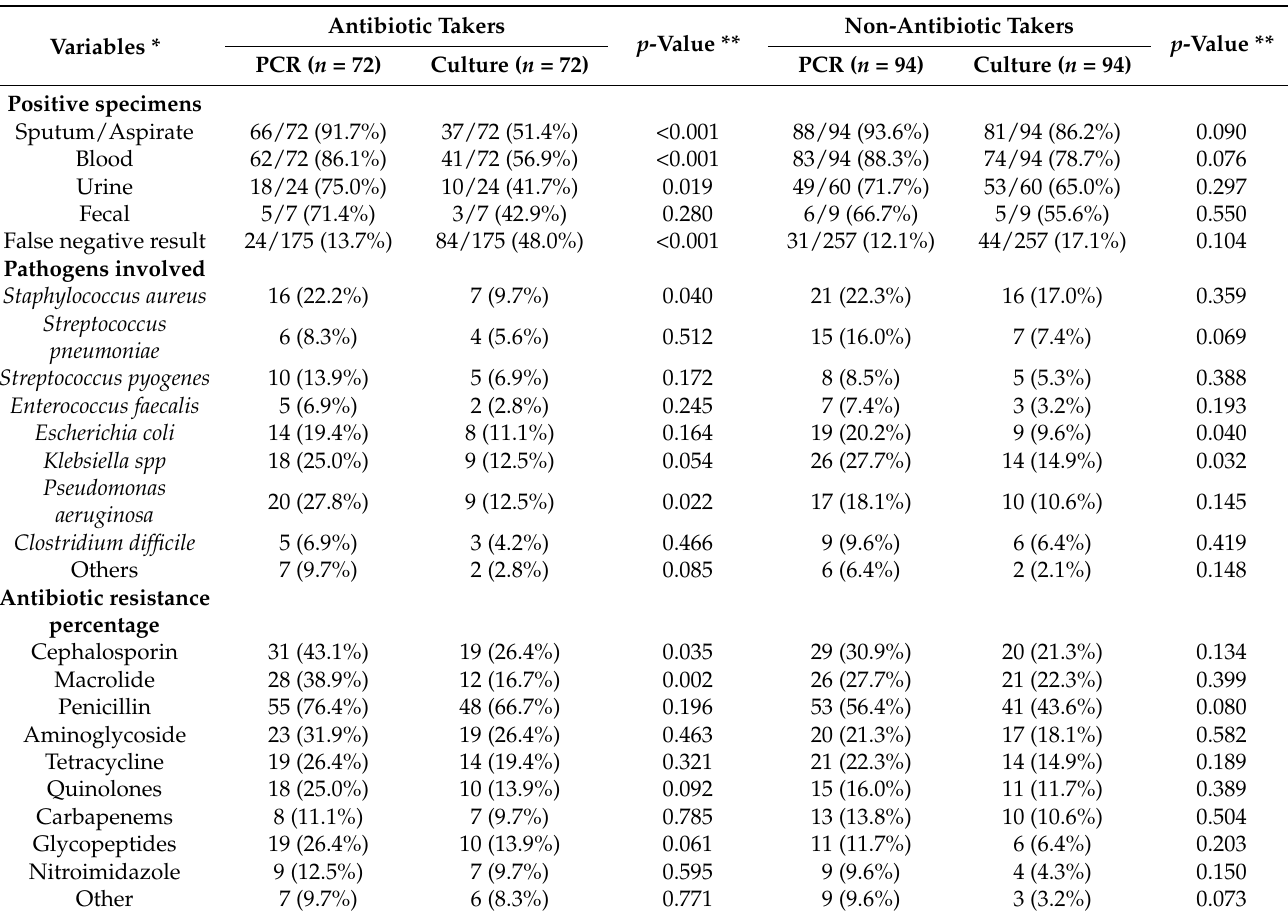
Figure 2. Kaplan–Meyer probability curve of hospitalization duration by the antibiotic use status of COVID-19 patients. Table 4. Parallel comparison of bacterial identification test results in patients with COVID-19 stratified by antibiotic